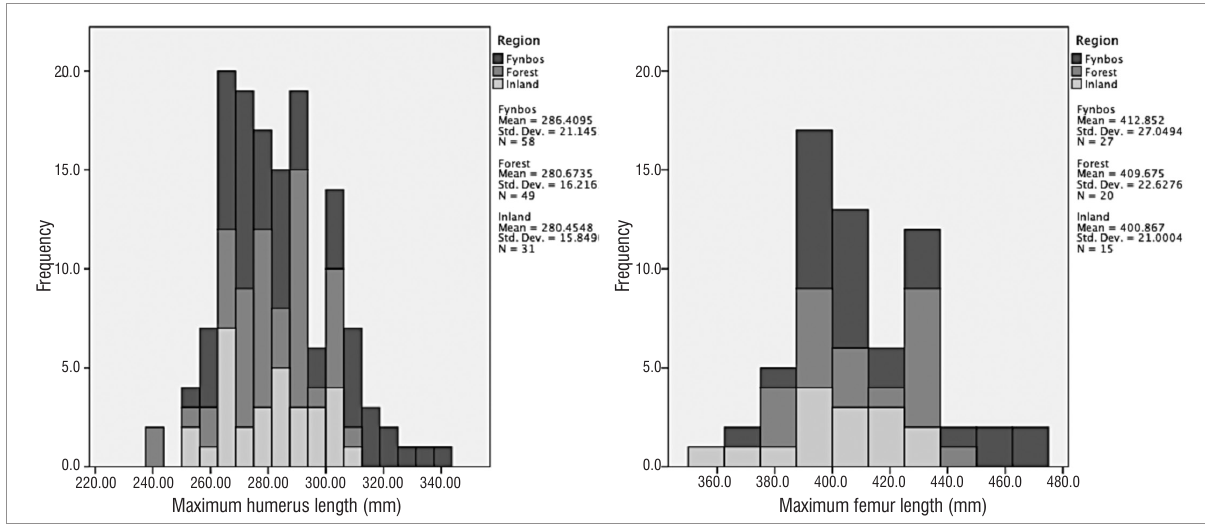
Histograms plotting maximum humerus lengths (mm) and maximum femur lengths (mm), organised by and fynbos samples are pooled is also significant ( p =0.002). There are no significant differences between inland men and women for either side. This suggests less differentiation between inland men and women in the distribution of diaphyseal loading, compared to the other regions.